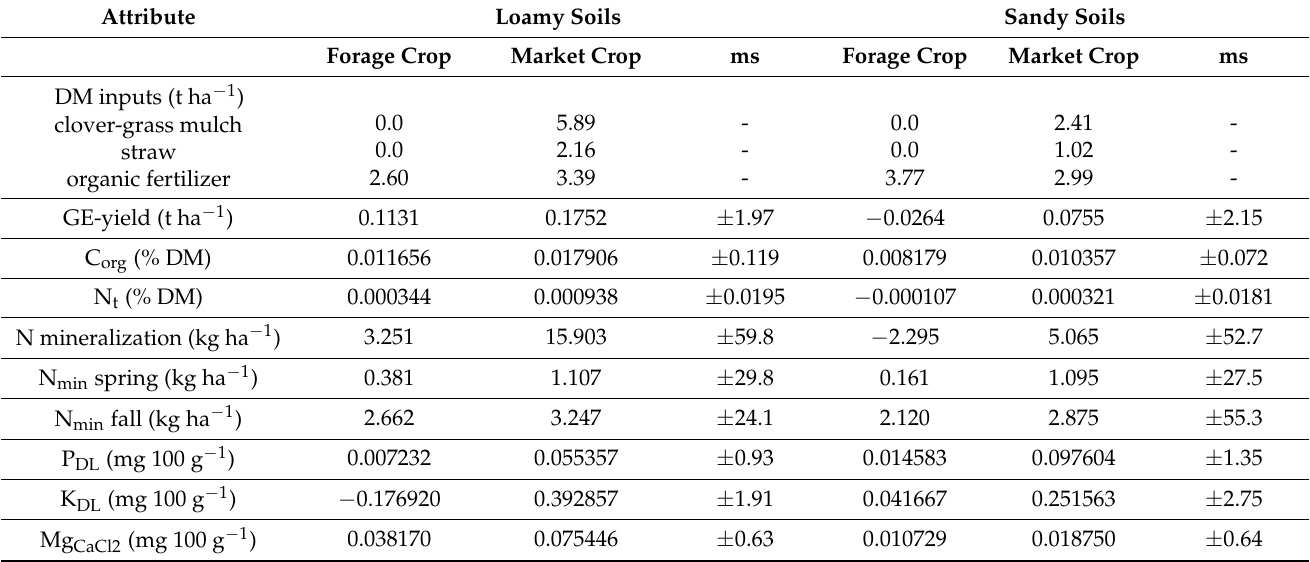
Table 10. Effect of the supply of organic materials with an organic fertilization corresponding to 2.0 LU ha − 1 on the annual change of certain characteristics from long-term experiments on loamy